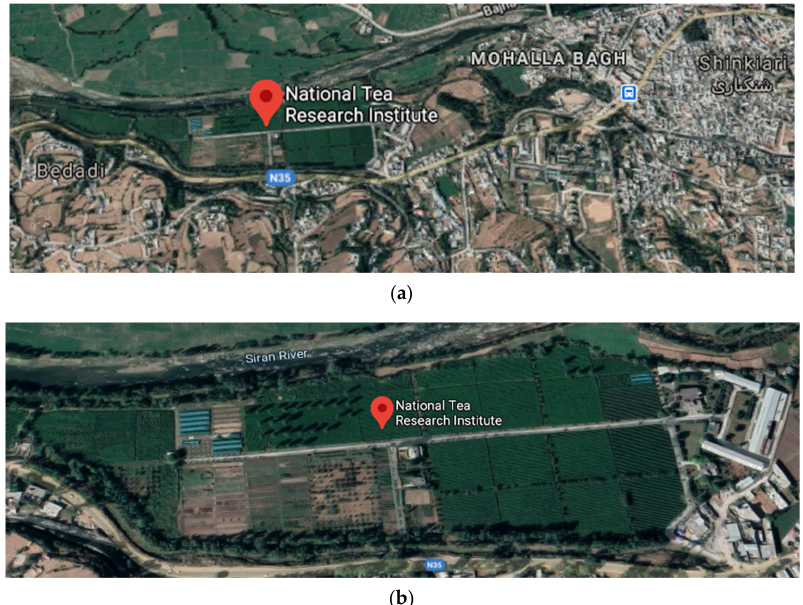
Figure 2. ( a ) Satellite view of Shinkiari, ( b ) satellite view of